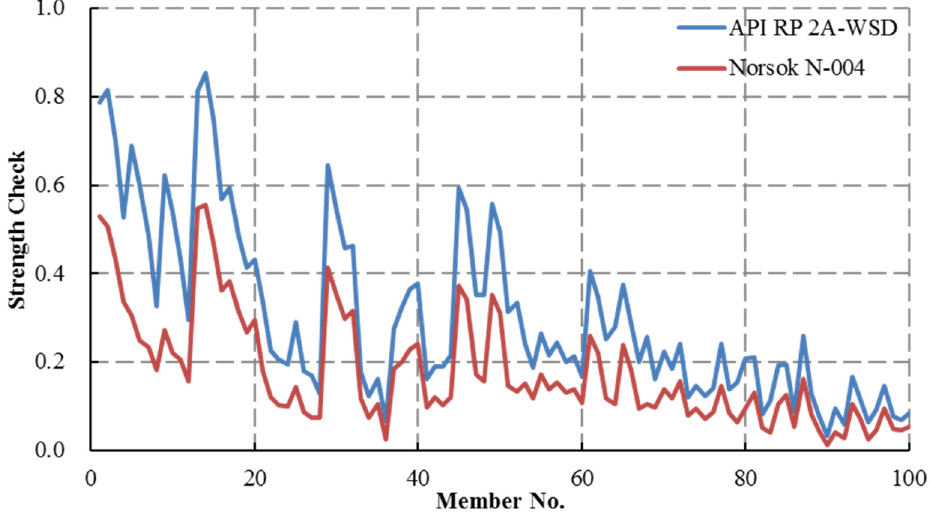
Figure 19. Member Strength Check (Case 1).